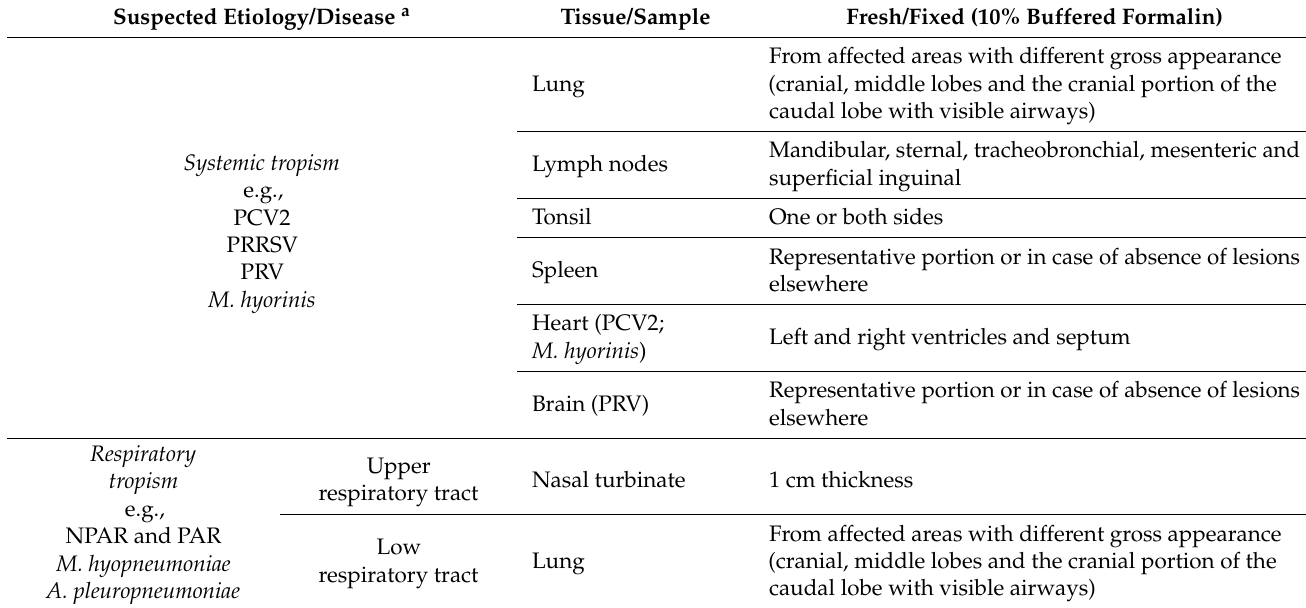
Table 2. PRDC: specimen collection (modified from